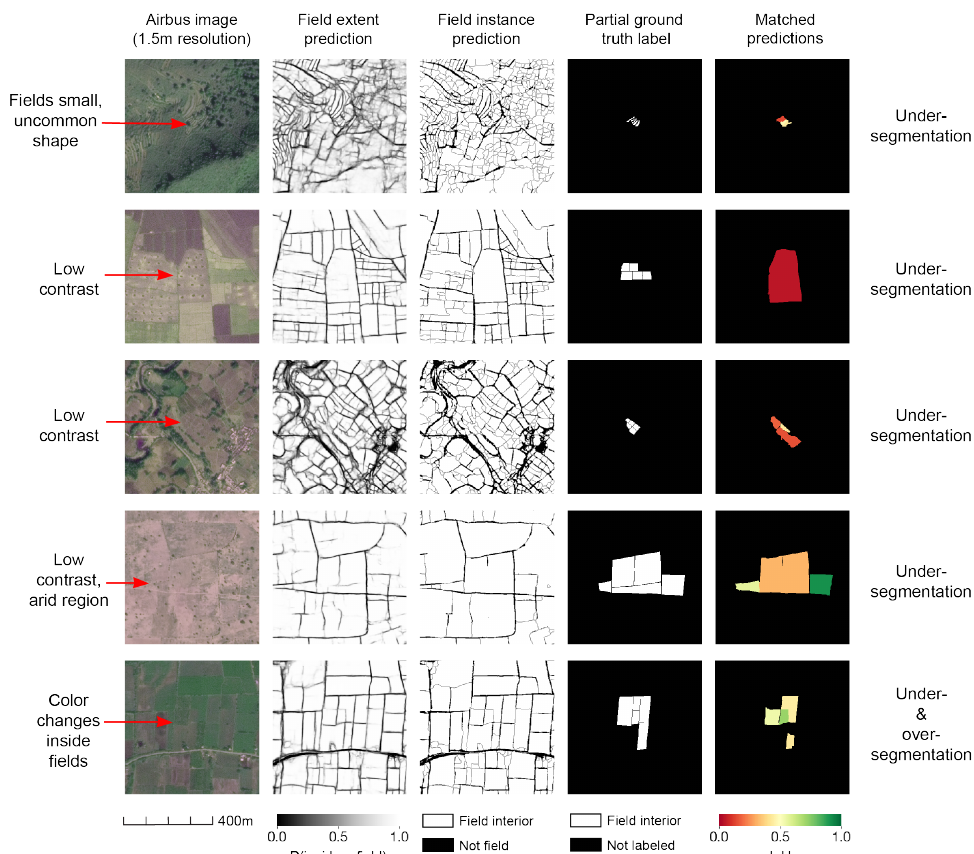
Figure 10. Example images where the model performed poorly. We show five examples that are among the 30 images with the lowest mIoU across fields. Most errors are due to under-segmentation attributable to low contrast between adjacent fields. Another source of under-segmentation appears to be uncommon field shapes or very small fields. Over-segmentation, which is less common, occurs when colors change significantly within one